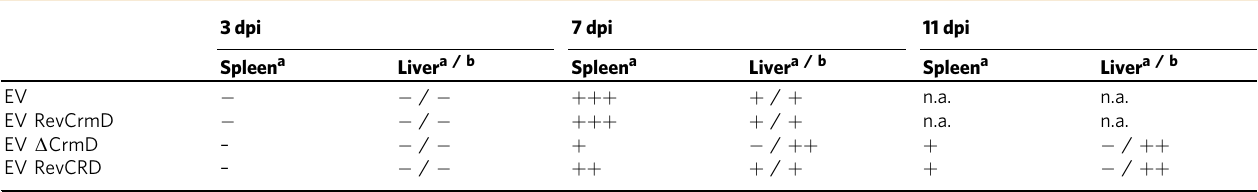
Table 2 Histopathology of spleen and liver in recombinant ECTV-infected